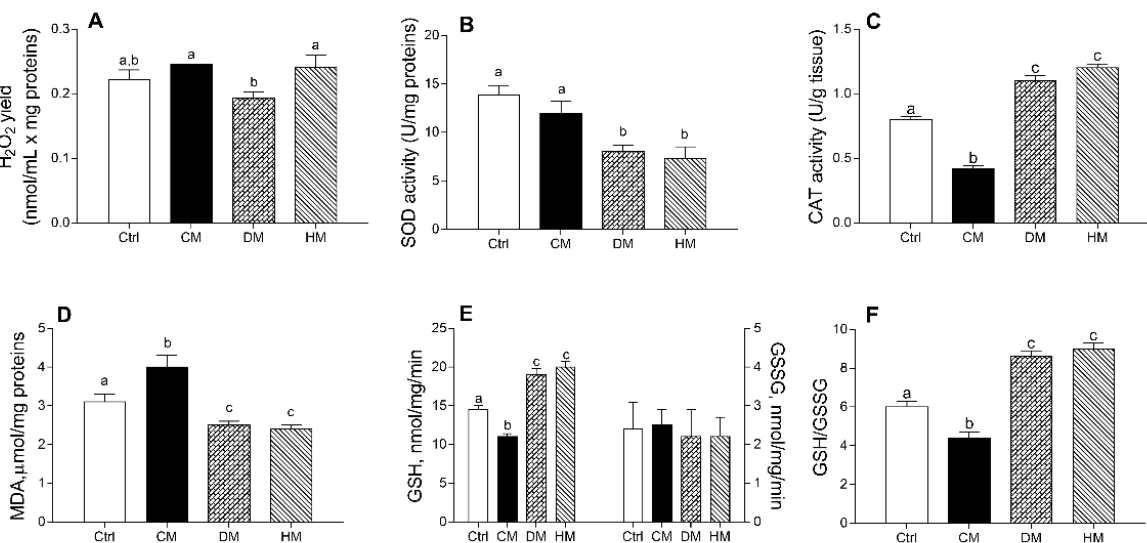
Figure 4. Cow milk (CM), donkey milk (DM) or human milk (HM) diet supplementation exhibits different efficacy in modulating rat cardiac mitochondrial ROS production, enzymatic antioxidant defenses, lipid peroxidation and cellular GSH/GSSG ratio. Mitochondrial H 2 O 2 yield ( A ), superoxide dismutase (SOD) ( B ) and catalase (CAT) activities ( C ) were reported. Lipid peroxidation index (MDA) ( D ), GSH and GSSG levels ( E , F ) were determined in heart homogenates. Data were expressed as the means ± SEM n = 7 animals/group. Different letters (a,b,c) on top of the bars indicate statistically significant differences ( p < 0.05) among groups.